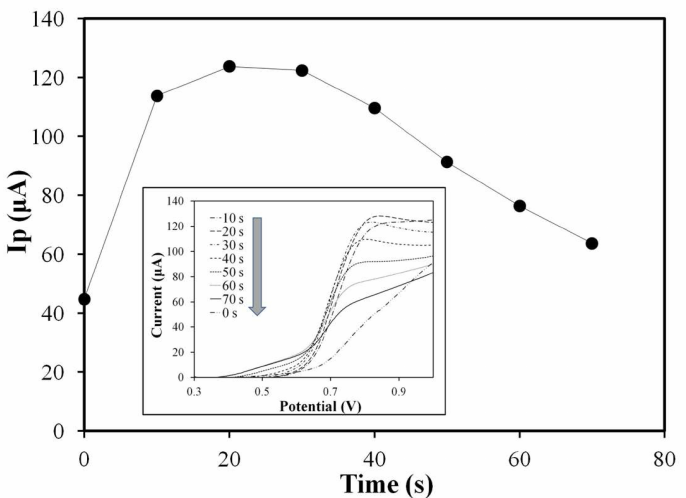
Figure 7. Temporal response characteristics of the OPA sensor. Time dependence of peak current (I p ) responses of hydrogel-modified SPCE strips to 5 µ L of 0.5% OPA. Insert shows cyclic voltammograms of the OPA sensors at various starting times (0–70 s) of the cyclic voltammetry scans. Scan rate: 100